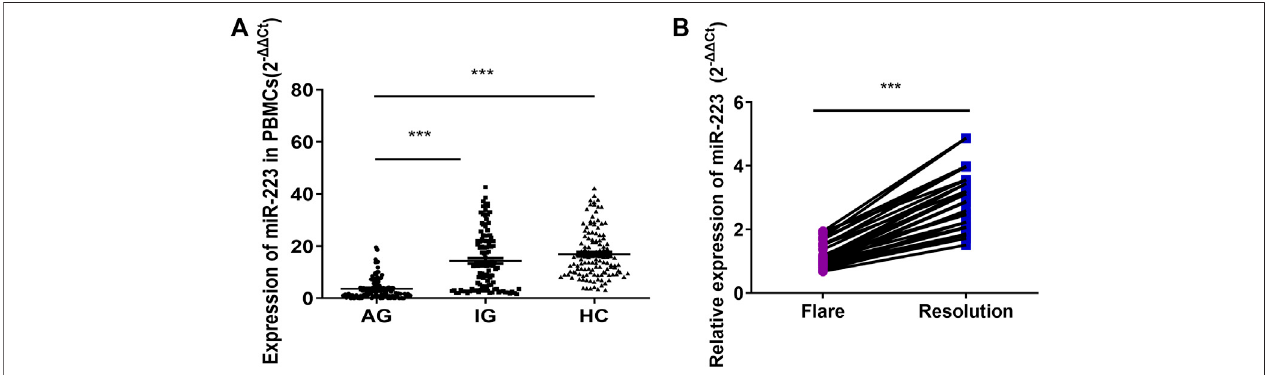
FIGURE 1 | Expression of miR-223 in gout patients. (A) Expression of miR-223 in peripheral blood mononuclear cells from patients with acute gout ( n (cid:2) 122), patients with intercritical gout ( n (cid:2) 118) and healthy control subjects ( n (cid:2) 125), one-way ANOVA F (cid:2) 83.811, p < 0.001. *** p < 0.001 for the Bonferroni test for the comparison between groups. (B) Relative expression of miR-223 in patients with gout fl are and after resolution. Paired t -test ( n (cid:2) 30). t (cid:2) − 15.649, p <